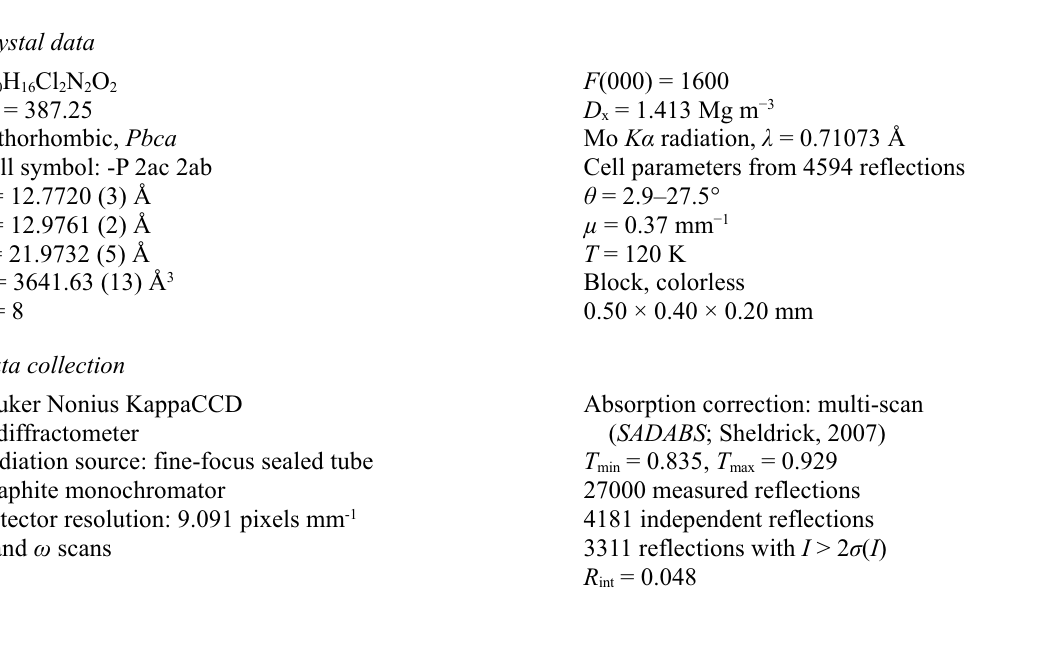
A partial packing diagram of the title compound. Hydrogen bonds are shown as dashed lines. 1-[2-(2,6-Dichlorobenzyloxy)-2-(2-furyl)ethyl]-1 H